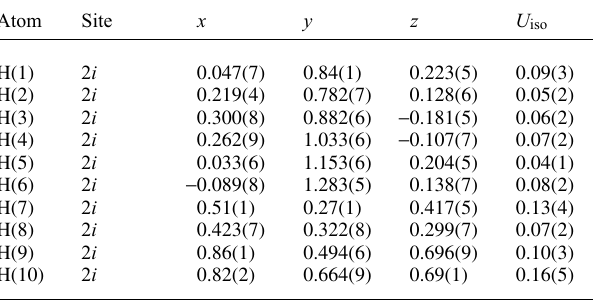
Table 2. Atomic coordinates and displacement parameters (in Å 2 )